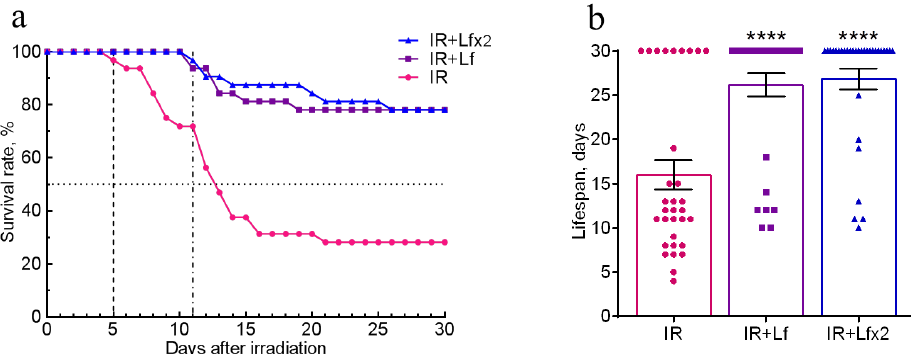
Figure 2. Effects of Lf on the survival rate ( a ) and lifespan ( b ) of mice after 7.5 Gy whole-body gamma irradiation. Lf (i.p.; 4 mg/mouse) was administered immediately after irradiation (IR+Lf and IR+Lf×2) and 24 h after it (IR+Lf×2). n = 32 in each group. The survival rates (%) and lifespan (days) during the 30-day period after irradiation are presented. **** p < 0.0001 in comparison with the IR group.